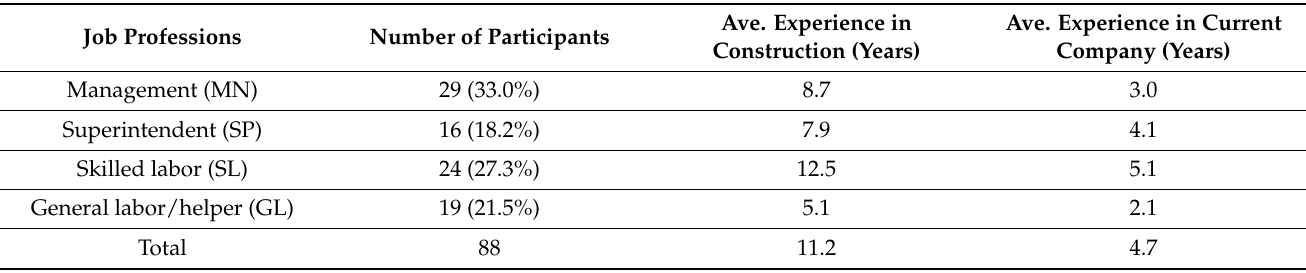
Table 2. Demographic of Survey